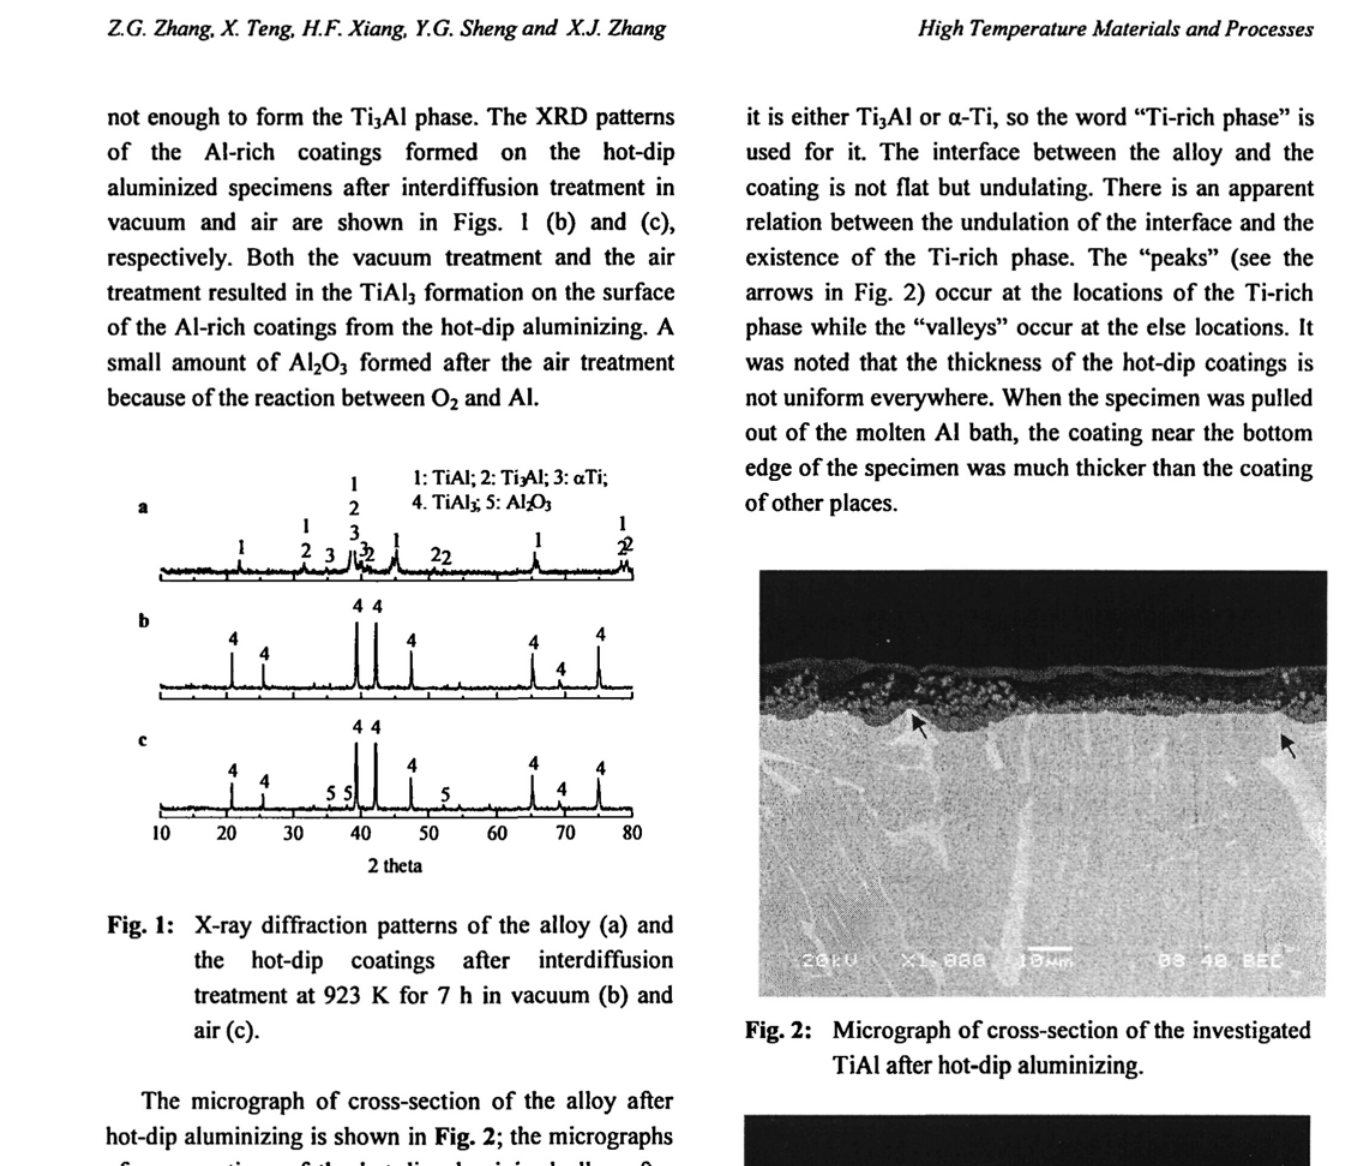
TiAl after hot-dip aluminizing.